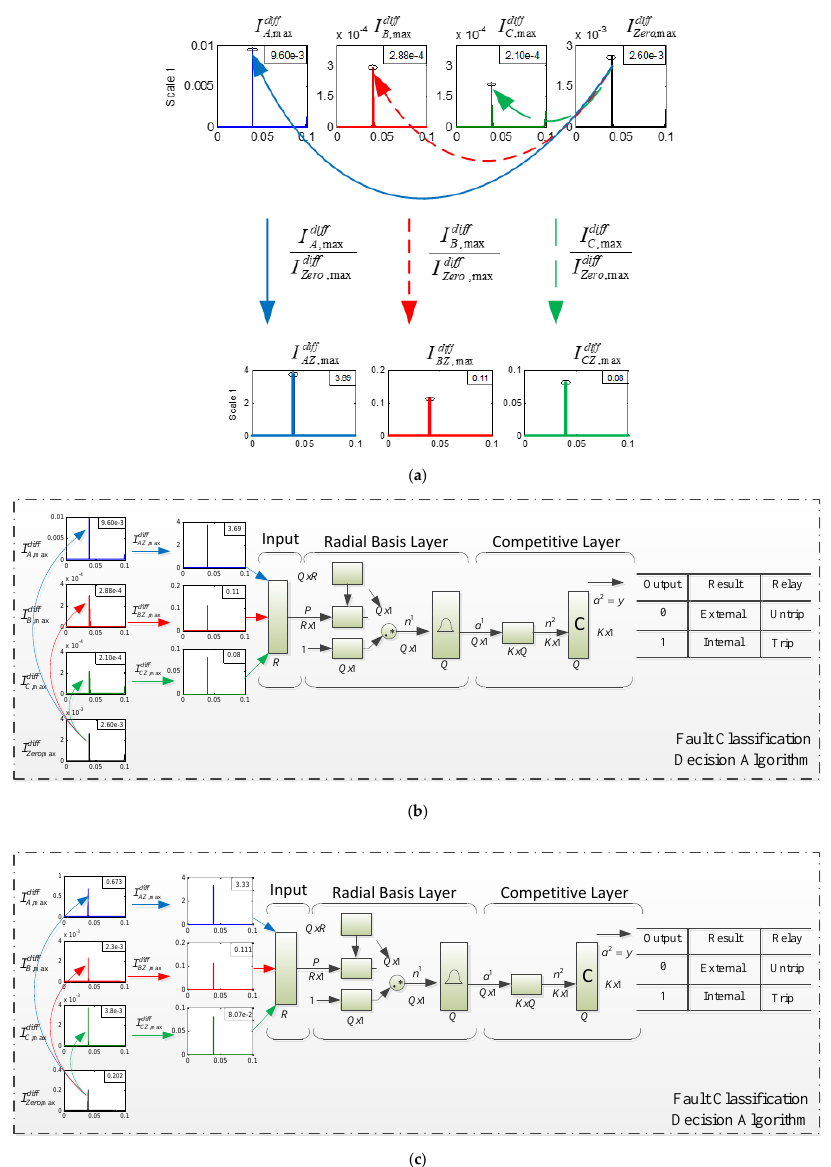
Figure 10. PNN Input pattern of the maximum ratio in scale 1 of differential current signal: ( a ) the maximum ratio obtained using the division procedure provided in scale 1; ( b ) internal; ( c ) external.